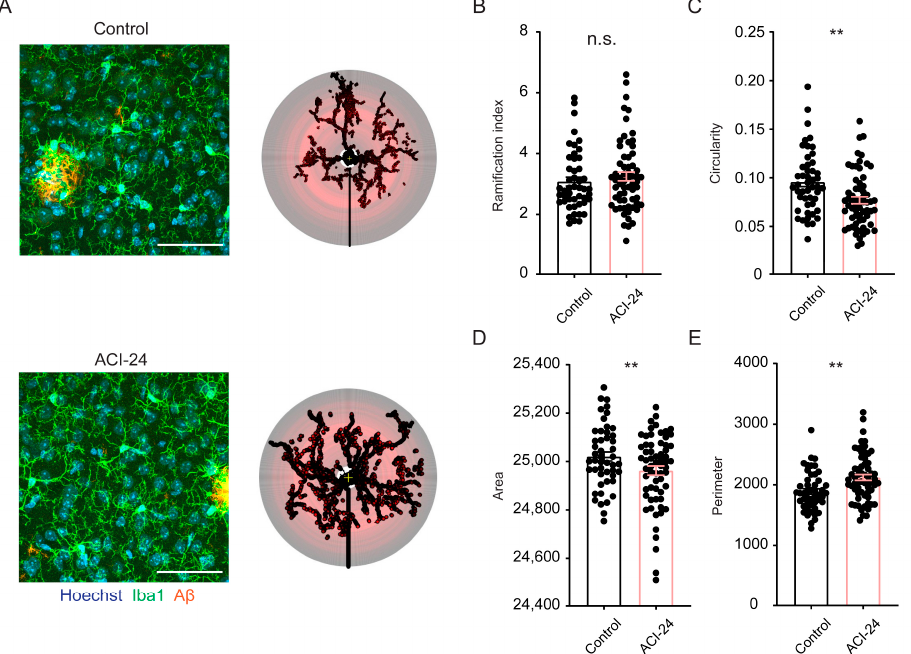
Figure 5. Plaque-distant microglia show increased ramification following ACI-24 vaccination. Representative images and the respective Sholl analysis of the plaque-distant microglia (8–14 microglia per brain) in 5 control (in total 48 microglia) and 6 ACI-24 (in total 63 microglia) treated mice (transgenic mother offspring) ( A ). Microglia are depicted with Iba1, A β is visualised using 3552 antibody and nuclei using Hoechst. Scale bar: 50 μ m. Statistical analysis representing graphs for the ramification index ( B ), circularity ( C ), area ( D ) and perimeter ( E ) of Iba1+ cells. Graphs are presented as mean ± SEM (n.s. non-significant, ** p < 0.001). Kolmogorov–Smirnov test was performed to check